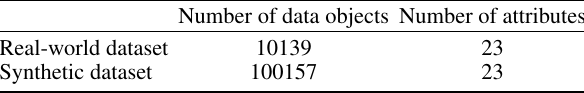
Table 1 Statistics of datasets.